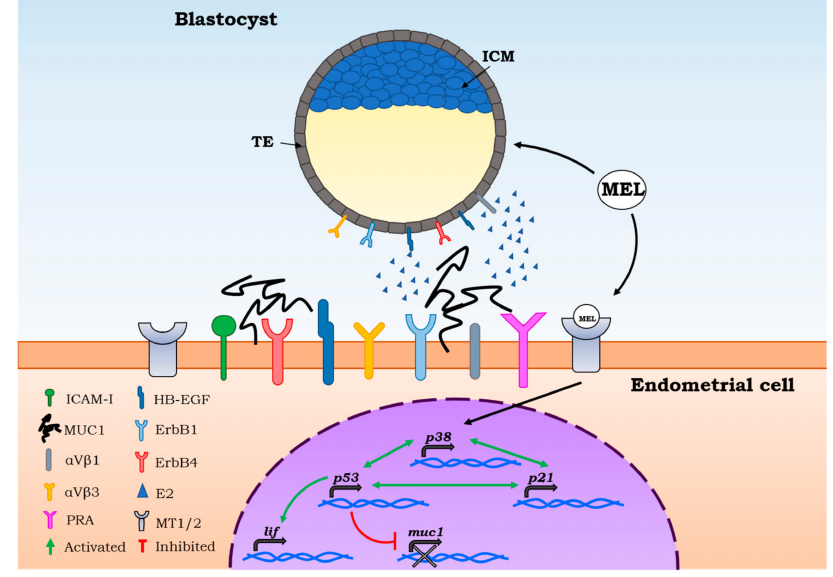
Figure 1. Pre-implantation stage. Physiological secretion of melatonin allows it to interact with melatonin membrane receptors (MT1-MT2) in endometrial cells and the blastocyst. Melatonin signaling creates a positive feedback loop among p53 , p38, and p21 , activating lif transcription and inhibiting mucin 1 secretion. The result is a better interaction among the adhesion proteins present at the membrane level on endometrial cells and the